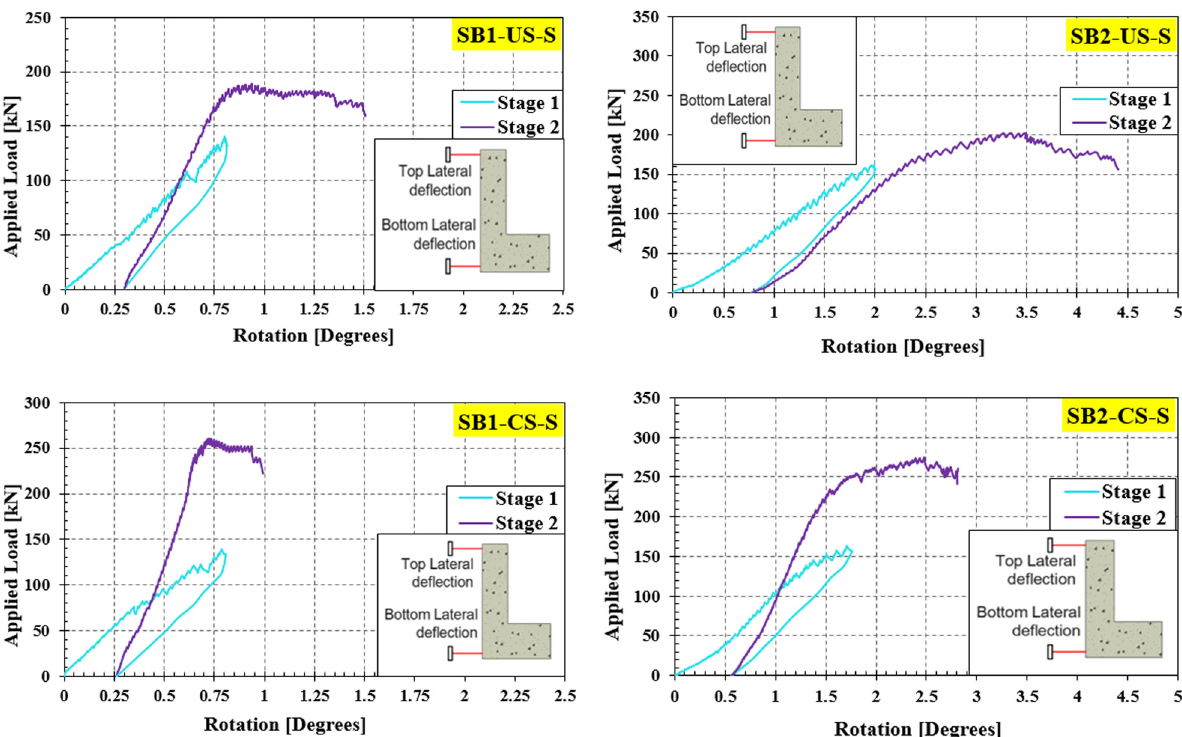
Figure 11: Load – rotation curves at mid - span section for tested spandrel